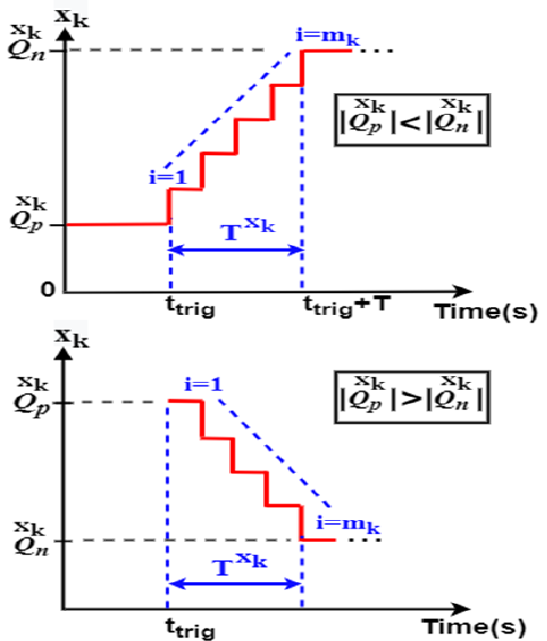
Figure 4. Stair-based transition function.